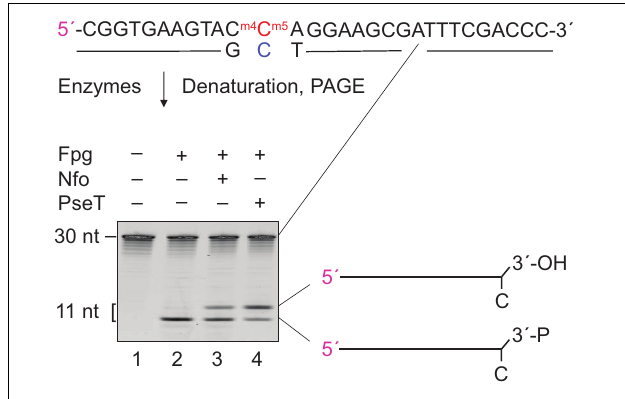
FIGURE 3 | Definition and processing of the 3 (cid:48) -end after Fpg-mediated incision of m N 4 , 5 C · C-DNA. DNA substrate ( Figure 1A ; 1 pmol) was incubated without (lane 1) or with Fpg (13 pmol; lanes 2–4) at 37 ◦ C for 30 min, followed by no addition (lanes 1 and 2), addition of 0.083 pmol endonuclease IV (Nfo; lane 3) or addition of 0.29 pmol T4 polynucleotide kinase (PseT; lane 4), and incubation for an additional 30 min (final volume, 10 µ L). Incised DNA was separated from un-incised DNA by denaturing PAGE ( Supplementary Figure 1 ) at 500 V for 4 h. Abbreviation: 3 (cid:48) -P, 3 (cid:48) -phosphate. The 5 (cid:48) -labeled strand is indicated by 5 (cid:48) in